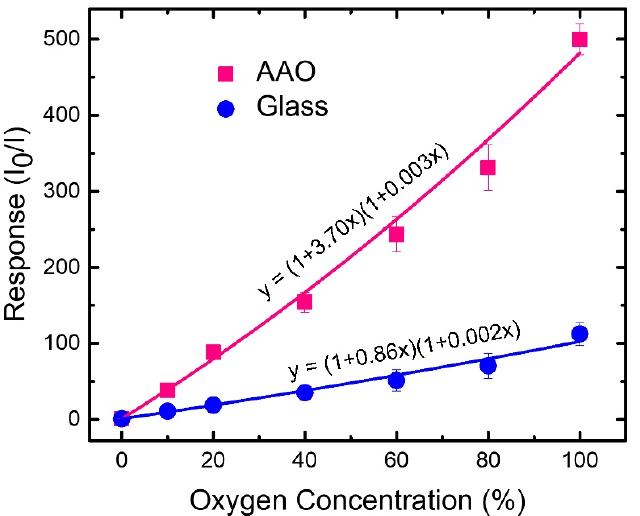
Figure 8. Responses as functions of oxygen concentrations for PtOEP-based oxygen sensors by using AAO membranes (pink squares) and glass substrates (blue dots). Equation (2) is used to fit the data points as shown by pink (AAO case) and blue (glass case) lines. Y-axis error bars represent the standard deviations of the data from 10